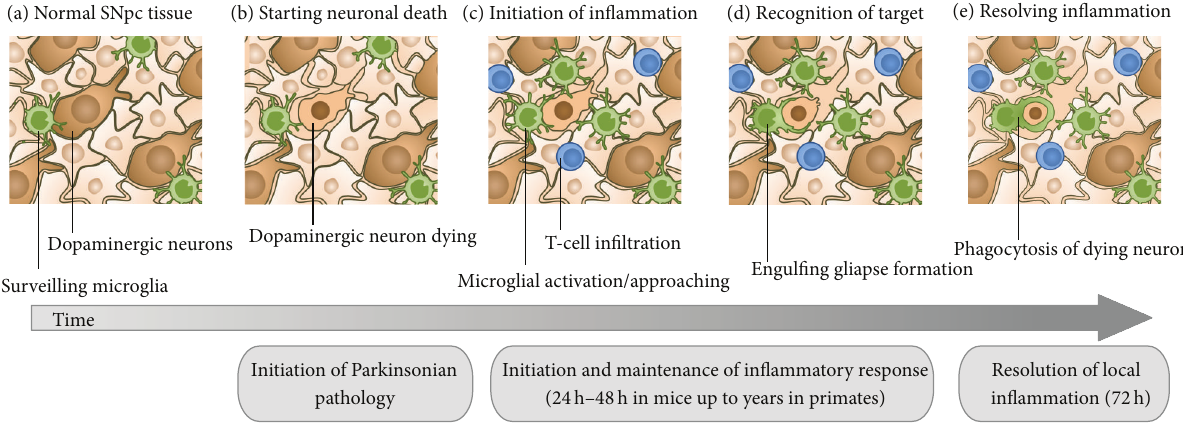
Figure 2: Local inflammatory response to dopaminergic neuronal death. (a) In normal SNpc tissue, microglia screen the brain parenchyma for changes. (b) In Parkinsonism, when dopaminergic neurons start dying, a number of signals, such as ATP or Ca 2+ , are released into the parenchyma. (c) These signals induce the inflammation, characterized by the enrolment of neighbor microglial cells and the recruitment of blood cells, such as T-cell lymphocytes or monocytes. (d) Microglial cells approach and contact damaged neurons. (d) Active microglial cells establish engulfing gliapses with degenerating neurons. (e) Microglial cells engulf and phagocytose degenerating neurons to resolve the local inflammation. The inflammatory response starts 24 h after the dopaminergic insult and is maintained during days until it is resolved. In mice, it could be resolved within 72h, while in primates it could continue for